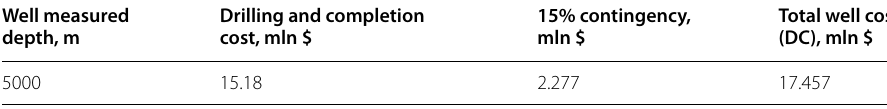
Table 4 D&C cost calculation results for reference reservoir Well measured depth,